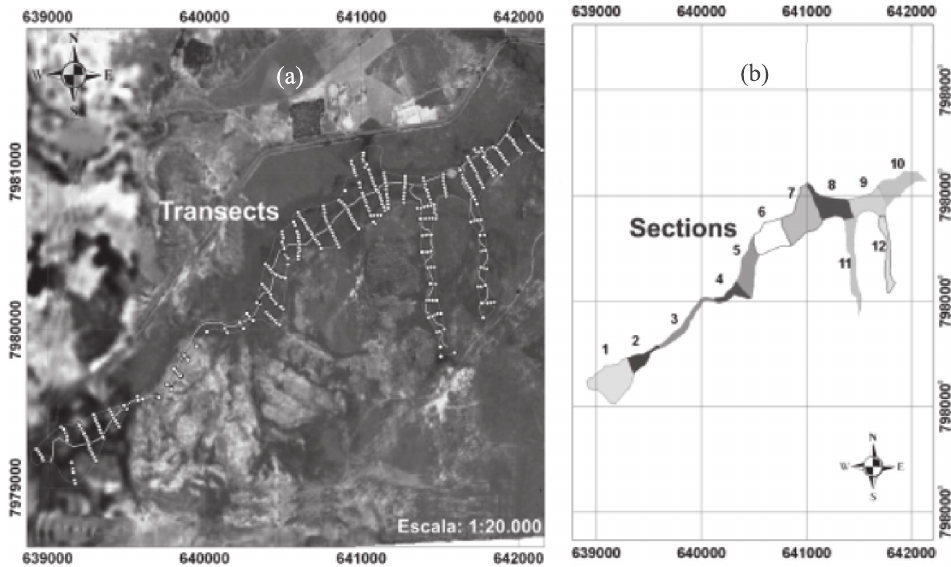
figure 2. satellite images of the peatland area, with the location of the transects and sampled sites (a); and sections used to calculate the volume occupied by the peatland